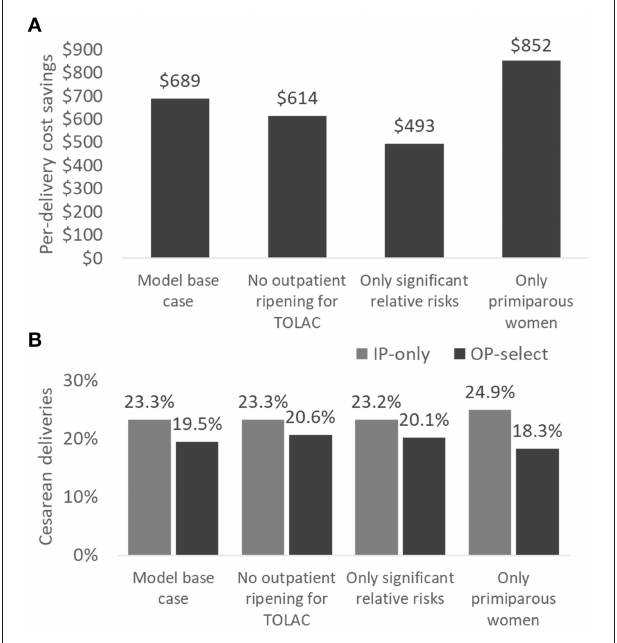
FIGURE 3 | Scenario analyses comparing per-delivery cost savings (A) and cesarean sections (B) in IP-only vs. OP-select strategies. Scenario analyses: (1) model base case, (2) women for TOLAC are ripened in the hospital only, (3) all non-significant relative risks for clinical events are set to 1.0, and (4) only primiparous women are assessed. TOLAC, trial of labor after cesarean